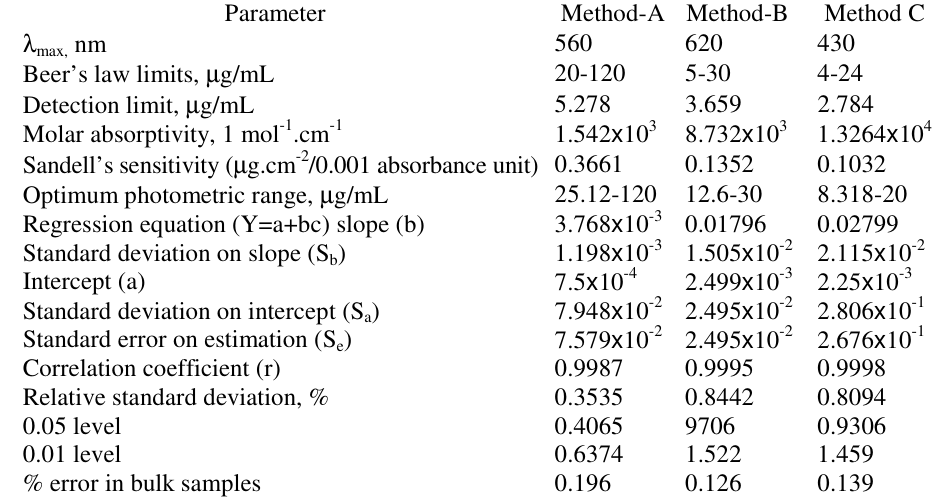
Table 2. Optical and regression characteristics, precision and accuracy of the proposed methods for